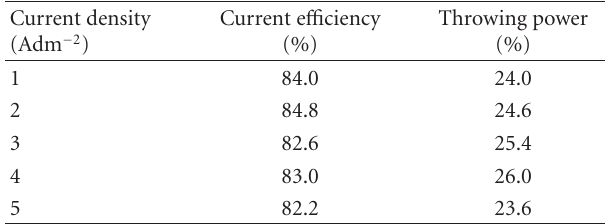
Table 3: Current e ffi ciency and throwing power at di ff erent current densities.